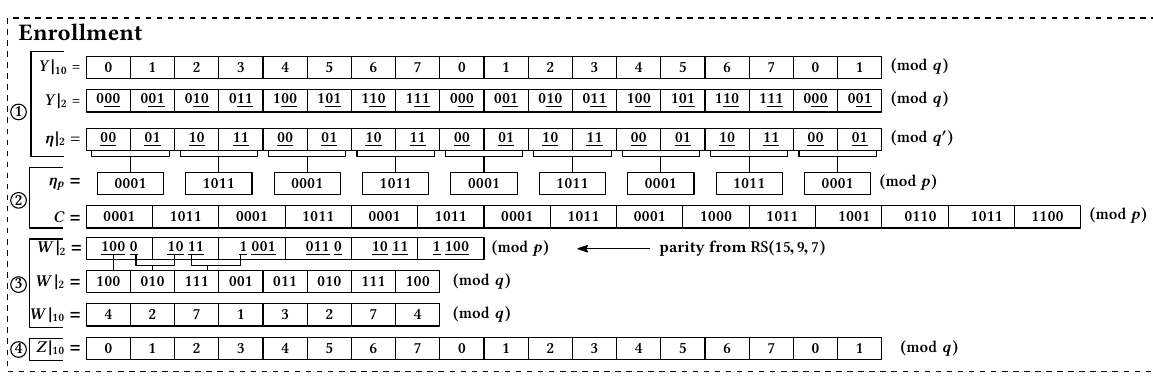
Figure 11: LMC encode example (q=8, q 0 = 4, l u = 2 , l d = − 1,